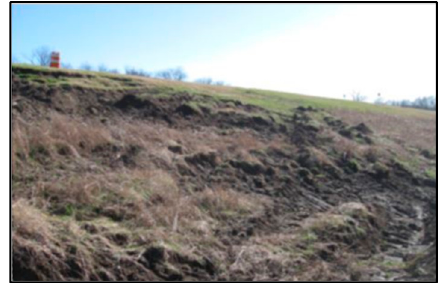
Figure 1. Slough or slump slide on a levee. Sensors 2016 , 16 , 898